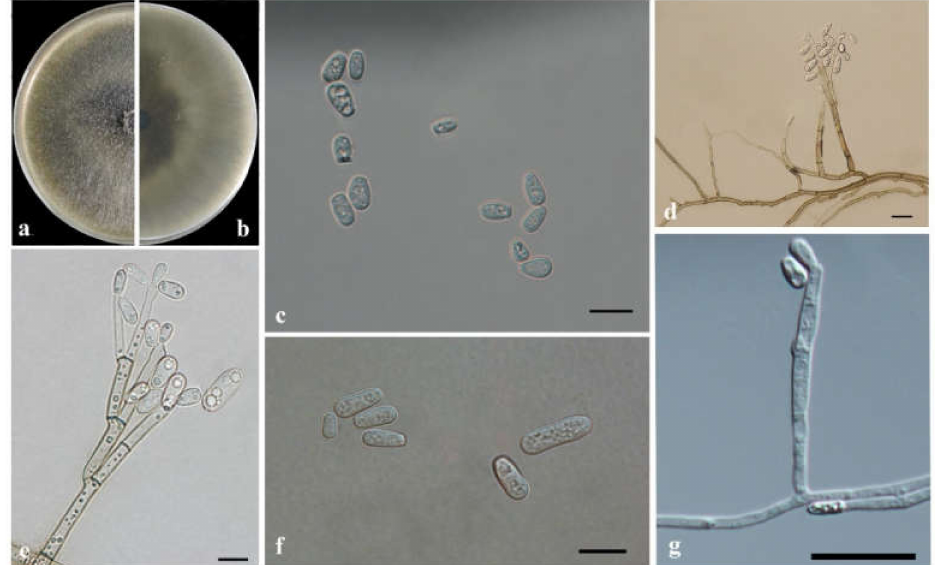
Figure 10. Morphological characteristics of Leptographium qinlingense . ( a , b ) Upper and reverse cultures on 2% MEA 5 days after inoculation; ( c – e ) Conidiogenous cells of leptographium-like asexual state and conidia; ( f , g ) Conidiogenous cells of hyalorhinocladiella-like asexual state and conidia. Scale bars: ( d ) = 20 µ m; ( c , e – g ) = 10 µ